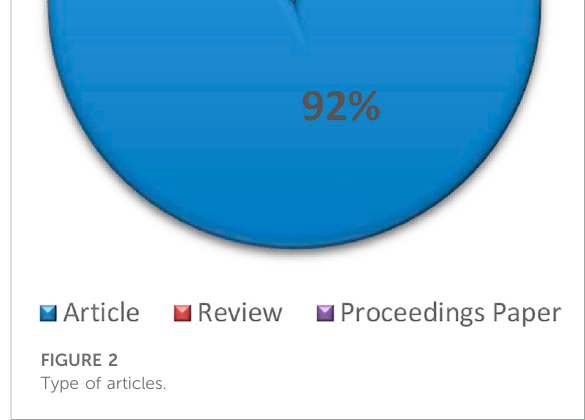
FIGURE 2 Type of articles.